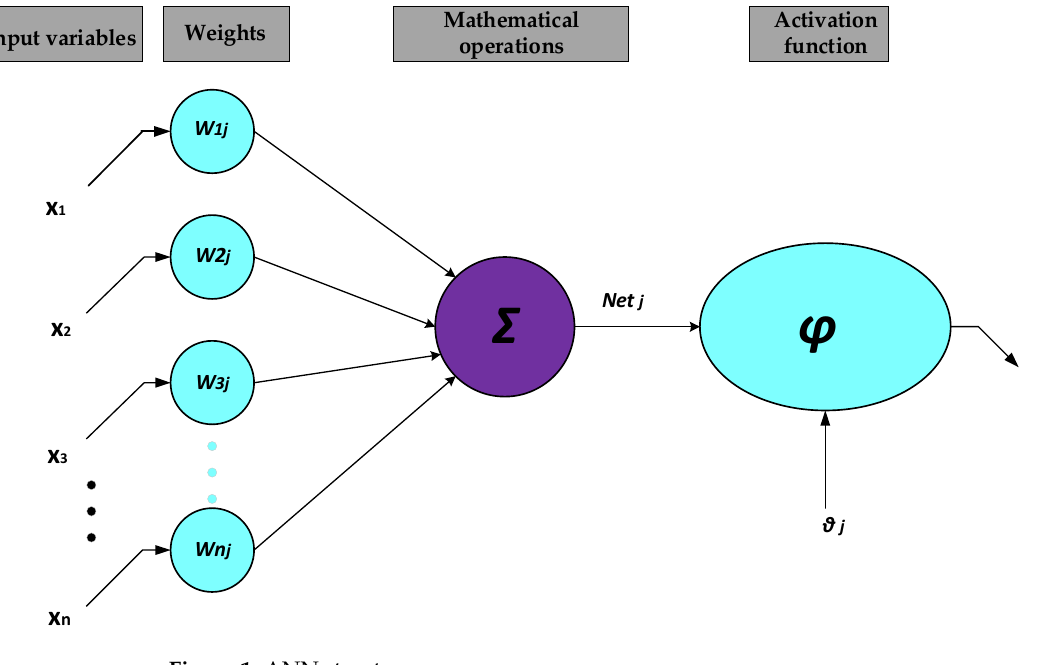
Figure 1. ANN structure.